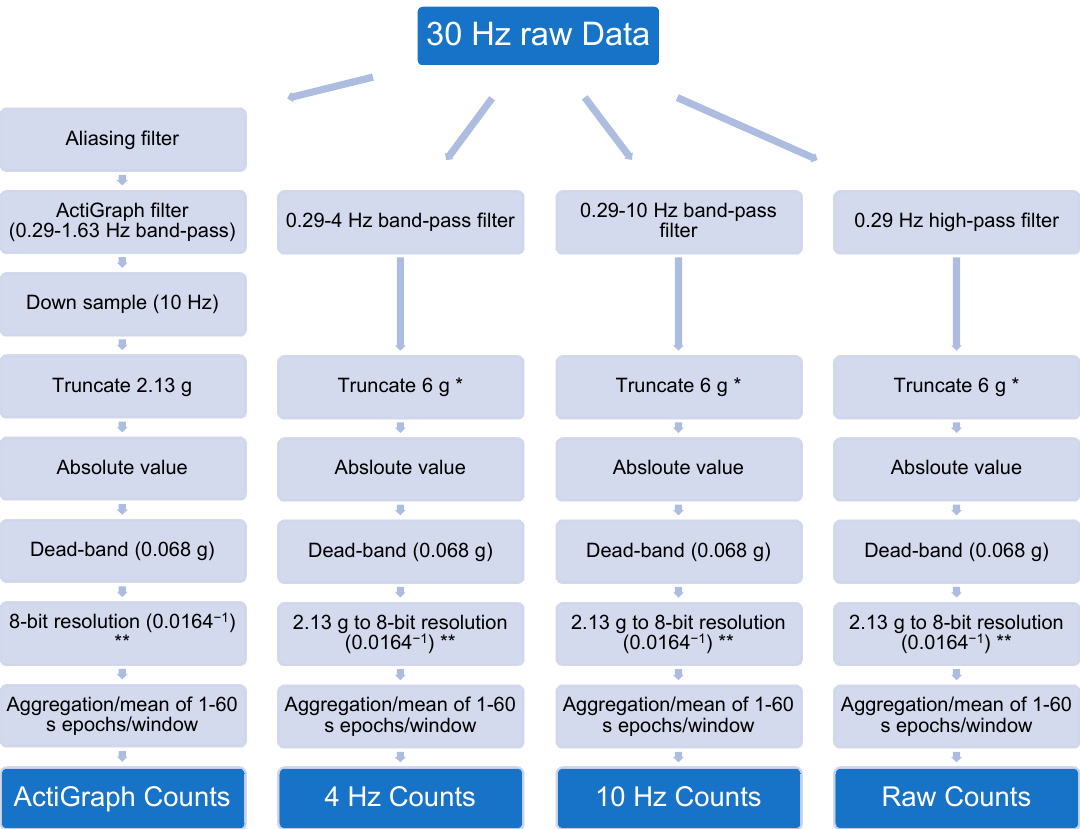
Figure 1. Description of the original ActiGraph and the modified processing methods. * Truncation to 6 g with the modified methods was only performed with the calibration data. ** Converting acceleration in g to counts with a 2.13 g to 8-bit resolution was only performed with the output presented in counts.